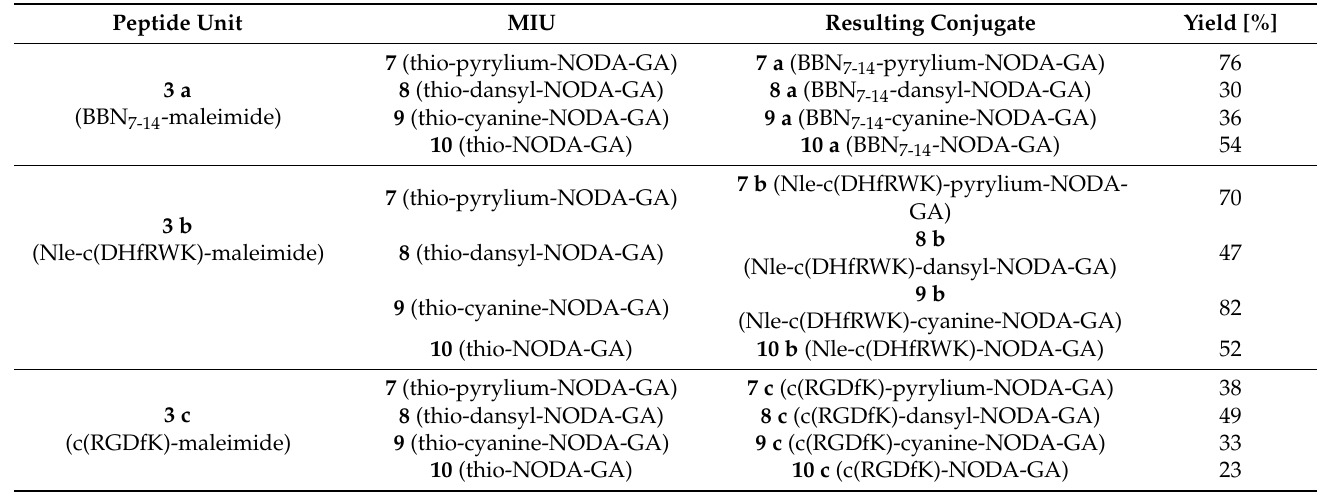
Table 1. Non-optimized conjugation yields of the purified hybrid imaging agents 7 a-c , 8 a-c , 9 a-c and 10 a-c obtained by conjugation of the MIUs 7-10 to the peptide maleimides 3 a-c